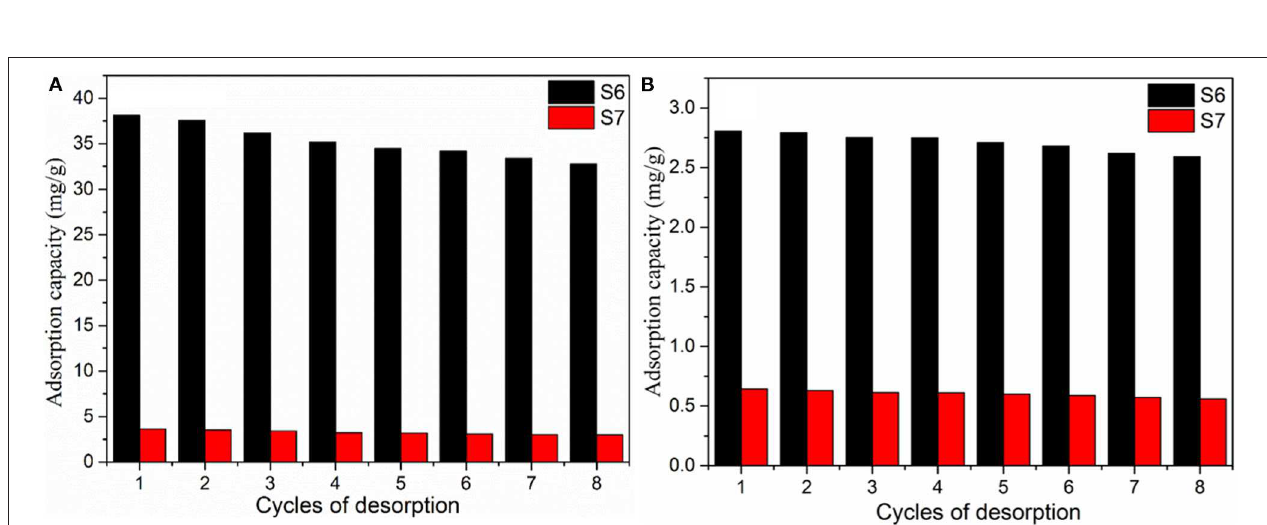
Frontiers in Materials |